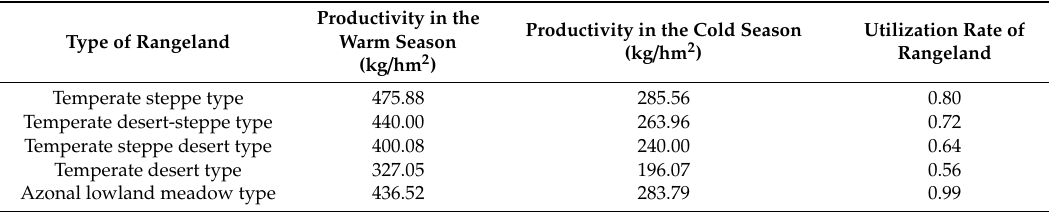
Table 3. The productivity of rangeland in OtogBanner.